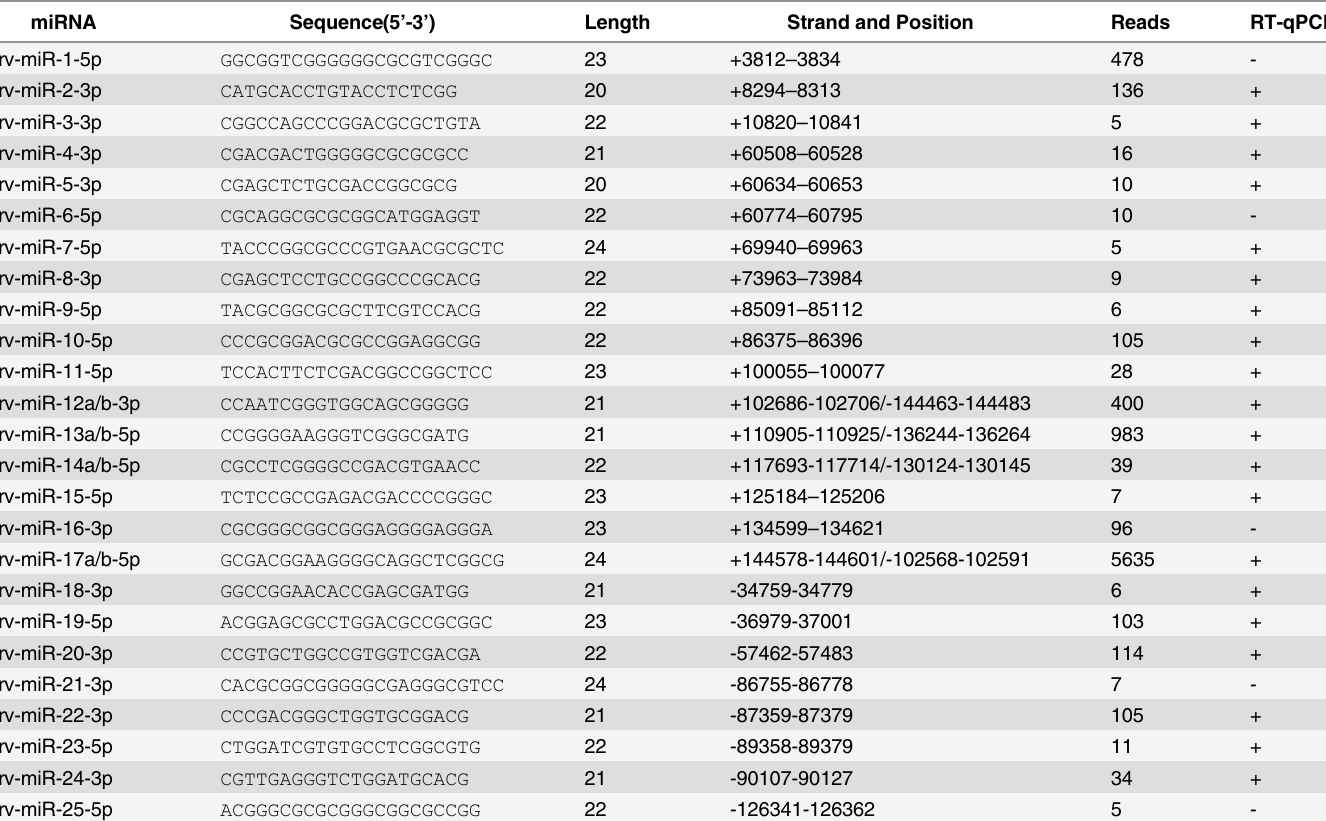
Table 3. Summary of virally encoded novel miRNA.